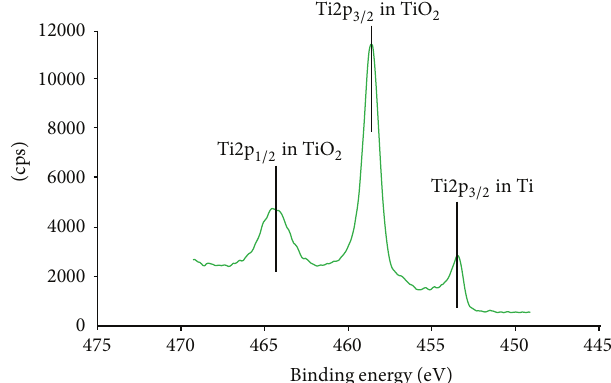
Figure 5: XPS analysis of Ti QCM sensor. XPS core-level spectrum of Ti2p for a Ti film.